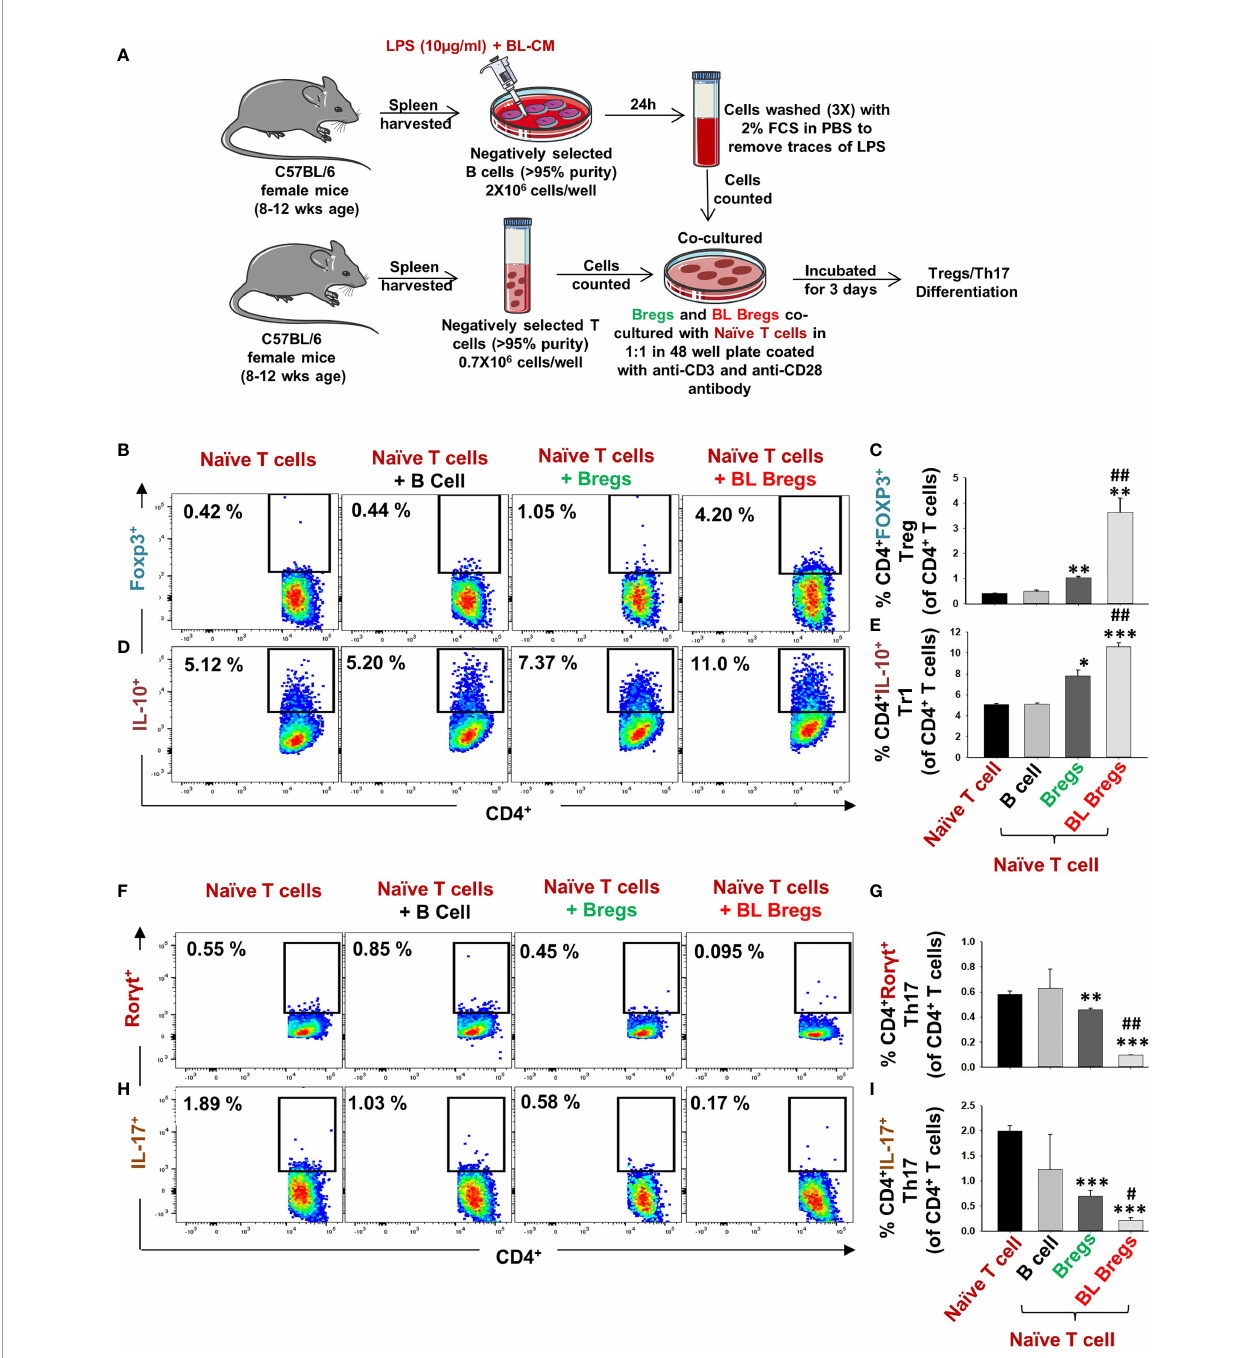
FIGURE 4 | BL enhances the immunomodulatory potential of Bregs: (A) Naïve T cells and LPS-stimulated and LPS + BL-CM were cocultured in anti-CD3 and CD28 coated plate for 3 days. B cells were induced with LPS (10 µg/ml) and BL-CM (1:5) for 24 h prior to cocultures. (B) Dot plots depicting the percentages of CD4 + FOXP3 + Tregs. (C) Bar graphs representing the percentages of CD4 + FOXP3 + Tregs. (D) Dot plots depicting the percentages of CD4 + IL-10 + Tr1 cells. (E) Bar graphs representing the percentages of CD4 + IL-10 + Tr1 cells. (F) Dot plots depicting the percentages of CD4 + Ror g t + Th17 cells. (G) Bar graphs representing the percentages of CD4 + Ror g t + Th17 cells. (H) Dot plots depicting the percentages of CD4 + IL-17 + Th17 cells. (I) Bar graphs representing the percentages of CD4 + IL-17 + Th17 cells. (* denotes comparison of the indicated group with respect to naïve T cells, and # denotes comparison of the indicated group with respect to the Bregs group). The above images are indicative of one independent experiment, and similar results were obtained in at least three independent experiments (n ≥ 3). Statistical signi fi cance was considered as p ≤ 0.05 (*p ≤ 0.05, **p ≤ 0.01, ***p ≤ 0.001) with respect to indicated groups (*, ** and *** indicated comparison between Naive T cells and Bregs ; # and ## indicate comparison between Bregs and